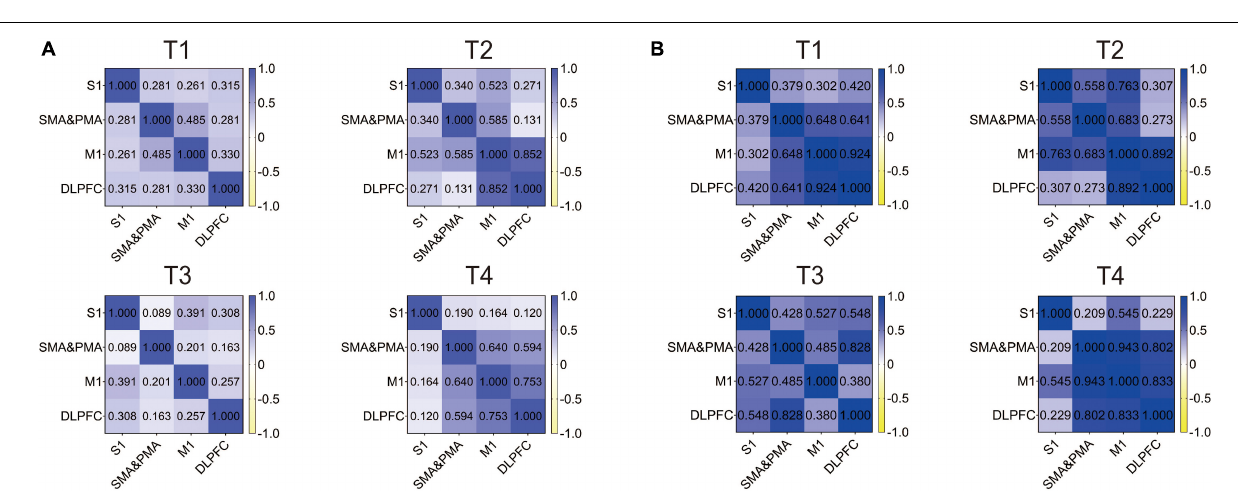
FIGURE 5 | Correlation heat map of regions of interests (ROIs) in T1, T2, T3, and T4 for the primary somatosensory cortex (S1), supplementary motor area (SMA), pre-motor area (PMA), primary motor cortex (M1), and dorsolateral prefrontal cortex (DLPFC). (A) Non-resistance movement; (B) resistance movement. The color bar from yellow to dark blue indicates the correlation from –1 to